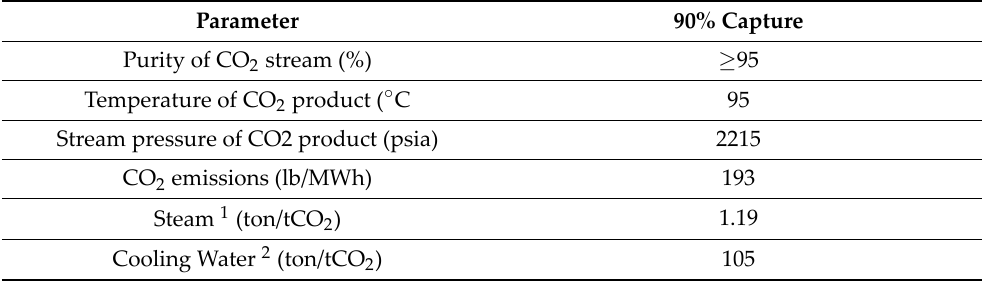
Table 3. KM‑CDR CO 2 capture facility and quality